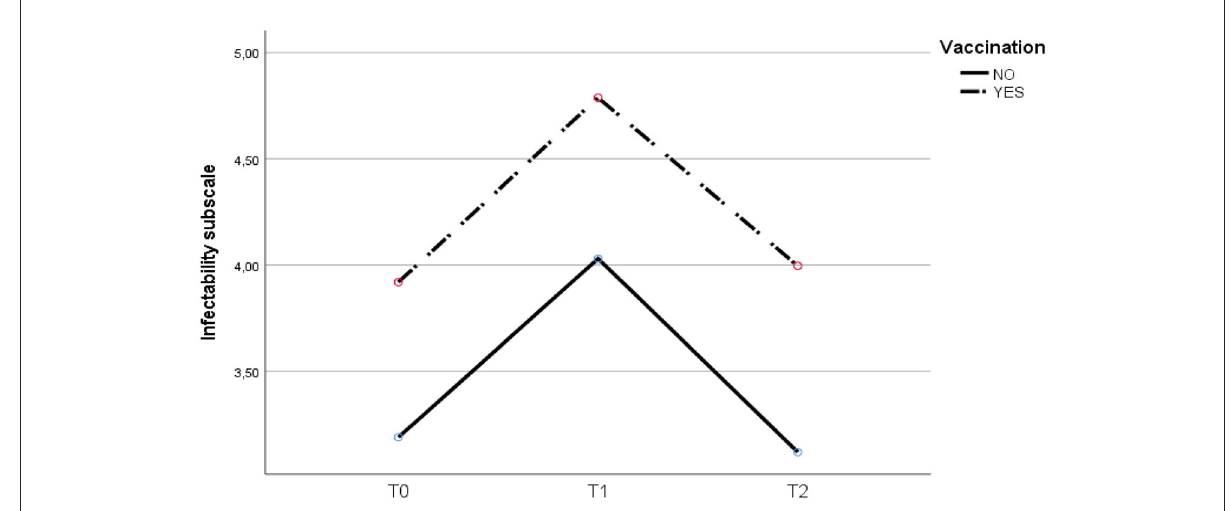
FIGURE1 Evolution of perceived infectivity at T0, T1 and T2 for vaccinated and unvaccinated.